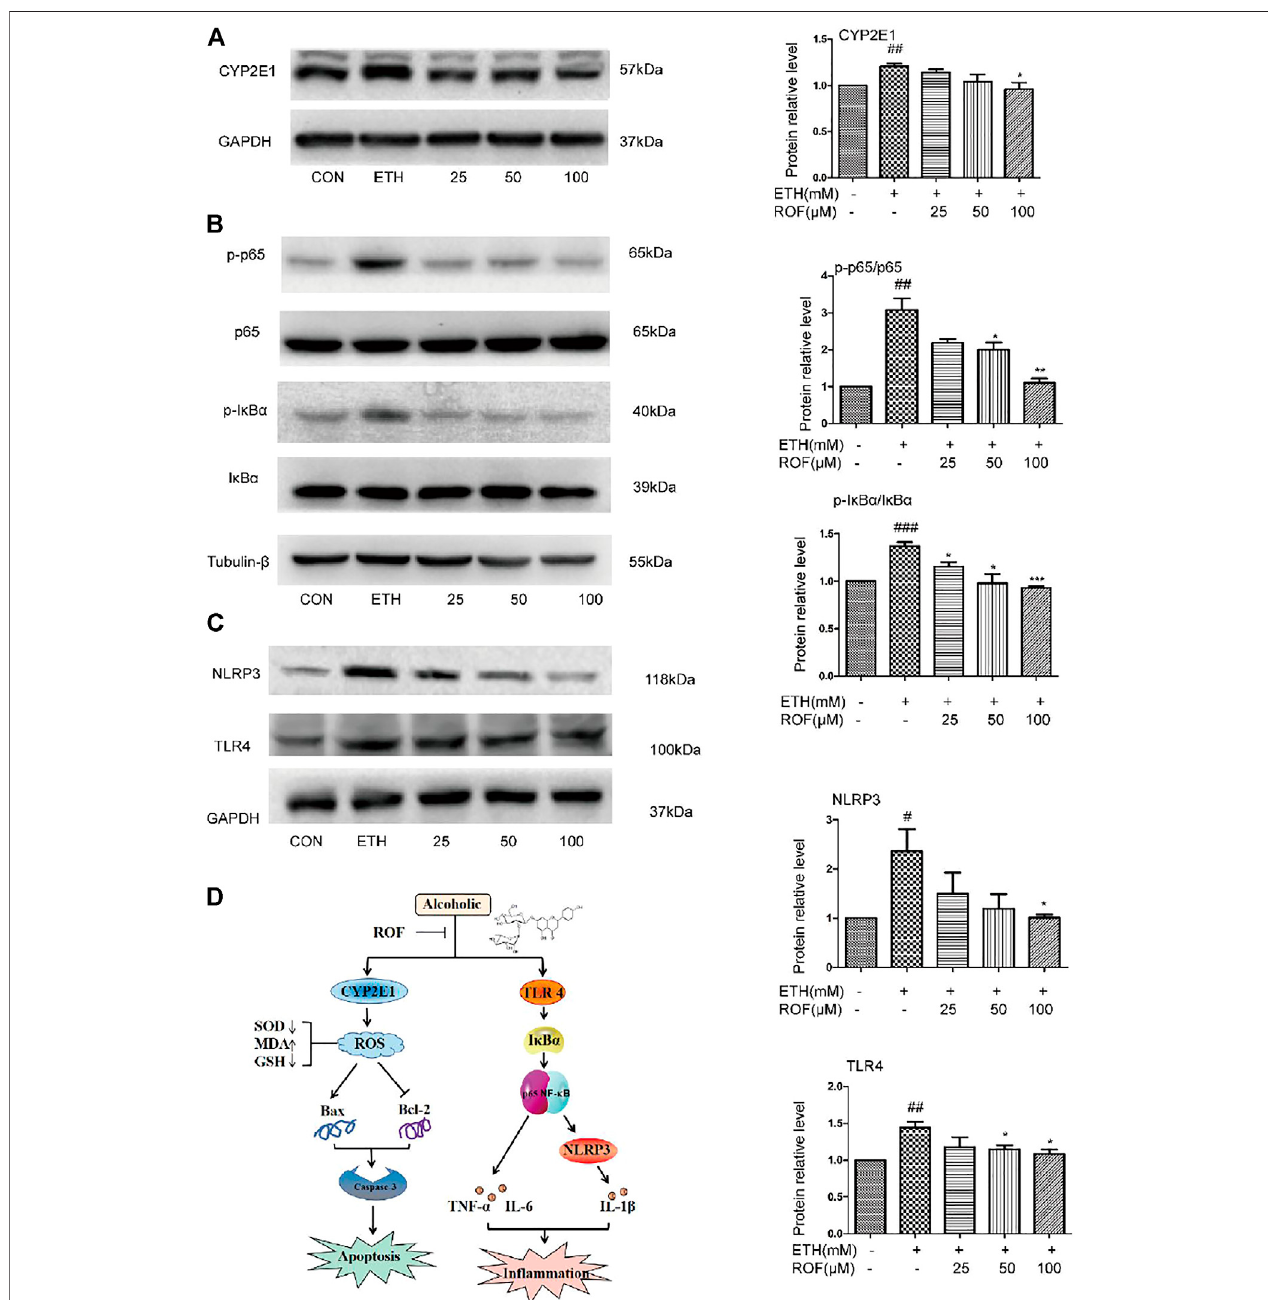
FIGURE 6 | Effects of ROF on CYP2E1 protein expression and TLR4/NF- κ B signaling pathway in LO2 cells. The cells were assigned to CON, ETH, and ROF (25, 50,100 μ mol L − 1 )groups.TheexpressionlevelsofCYP2E1 (A) ,andTLR4,NLRP3,I κ B α ,p65,andtheirphosphorylatedproteinswereevaluatedbyWesternblotting (B , C) . The mechanism by which ROF alleviatesALD isshown in (D) . Mean ± SEM ( n = 3). * p < 0.05, ** p < 0.01, and *** p < 0.001 vs. the ETH group. # p < 0.05, ## p < 0.01, and ### p < 0.001 vs. the CON group.